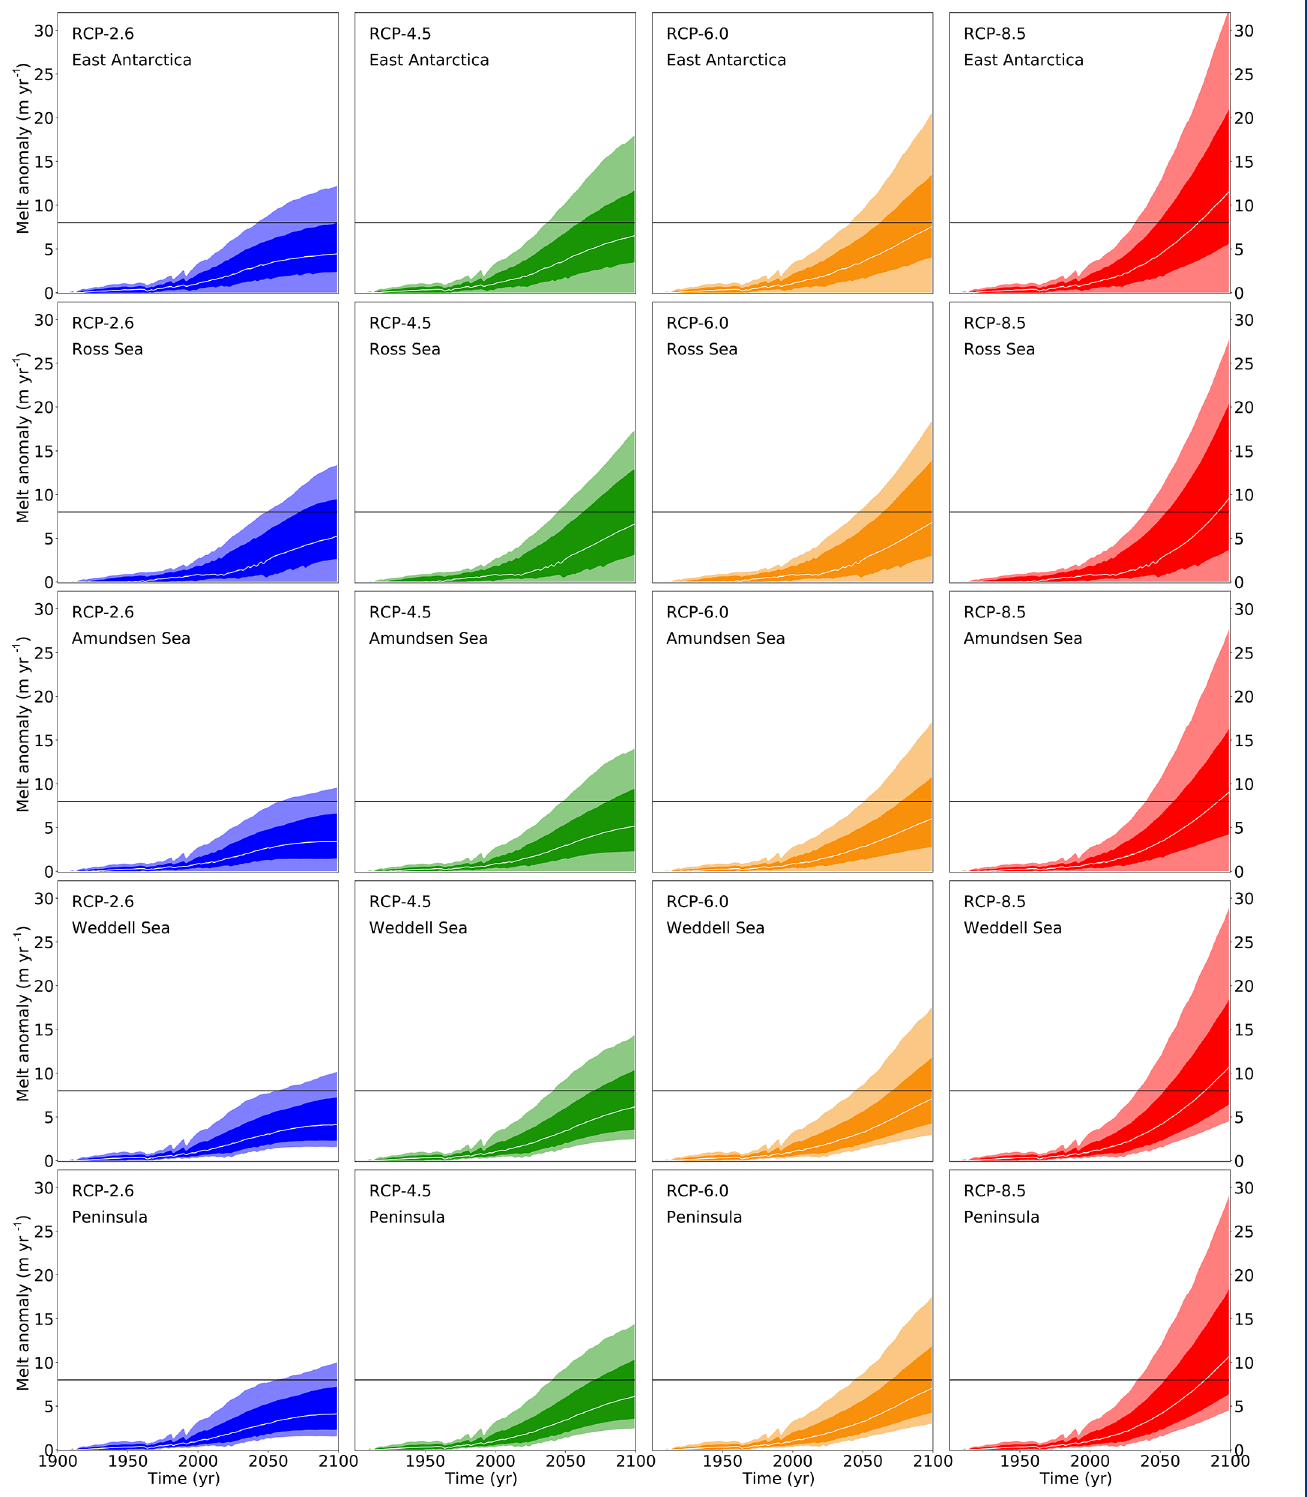
Figure 3. Projected basal melt rates following Sect. 2. The experiment used here for all the ice sheet models is the one with an additional 8myr − 1 of basal melting (black horizontal line in each panel). It is the experiment that is closest to the projected basal melt rates, which fosters the applicability of the linear response